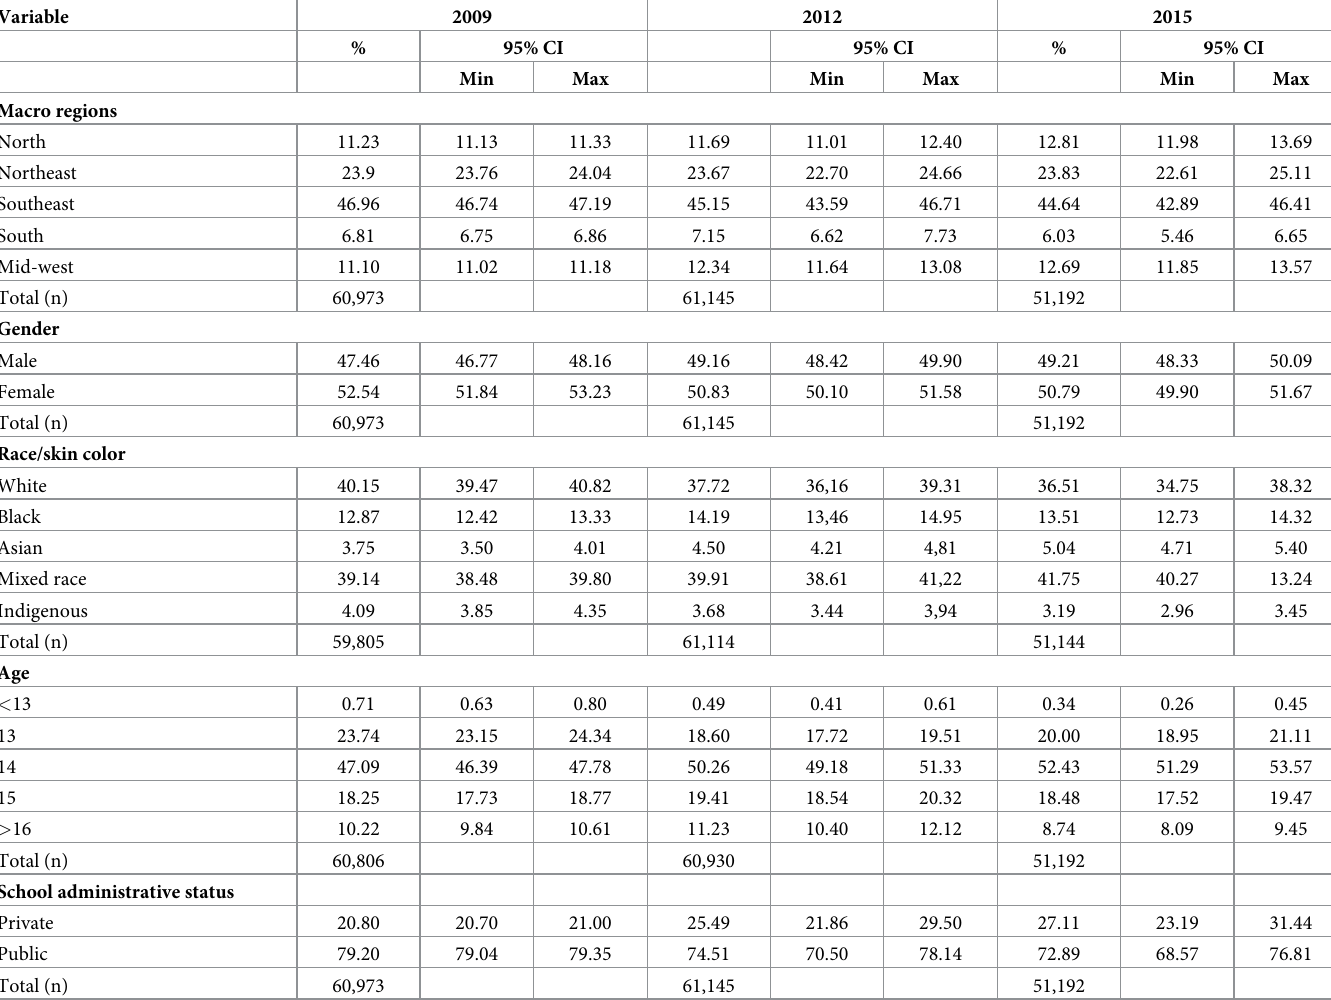
Table 1. Sociodemographic characteristics in Brazilian adolescents from 2009 to 2015. Brazil, 2009, 2012 and 2015. Variable